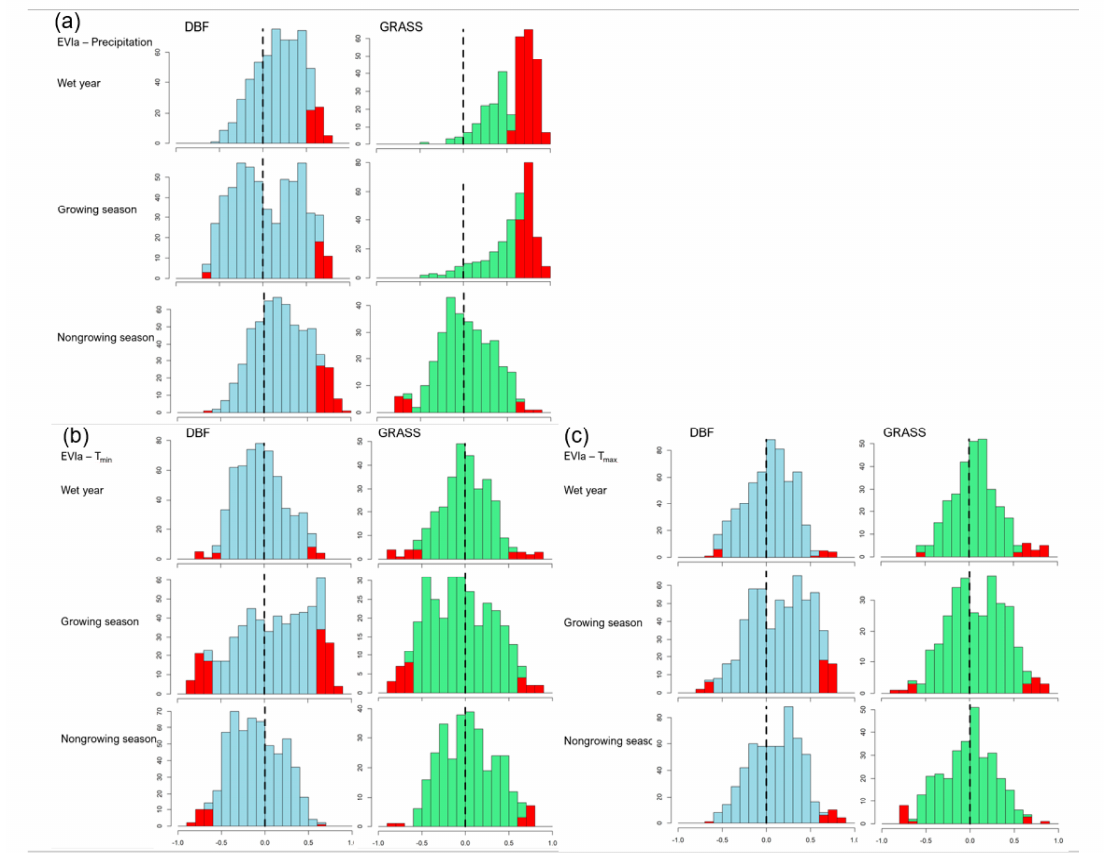
Figure A2. Histograms of Partial Correlation between EVI a and climate variables of Precipitation ( a ), Minimum Temperature T min ( b ), and Maximum Temperature T max ( c ) during wet year, growing season, and nongrowing season in 2001–2015 for the grassland (GRASS) and deciduous-broadleaved forest patches (DBF). Red bars on the left side of the dashed line indicate those partial correlations significantly lower than 0 while those on the right side of the dashed line indicate those partial correlations significantly greater than 0 ( p -value < 0.025, one-tail test).